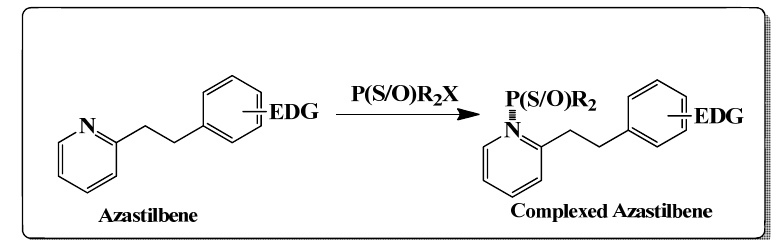
Figure 11 . Schematic representation of uncomplexed ( left ) and complexed ( right ) azastilbene [55]. (EDG = electron donating group).